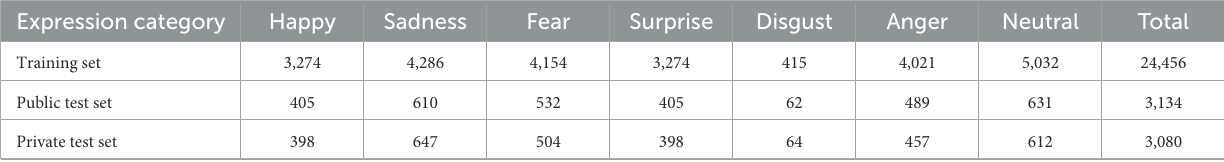
TABLE 1 Distribution of expression categories in the FER2013 dataset.